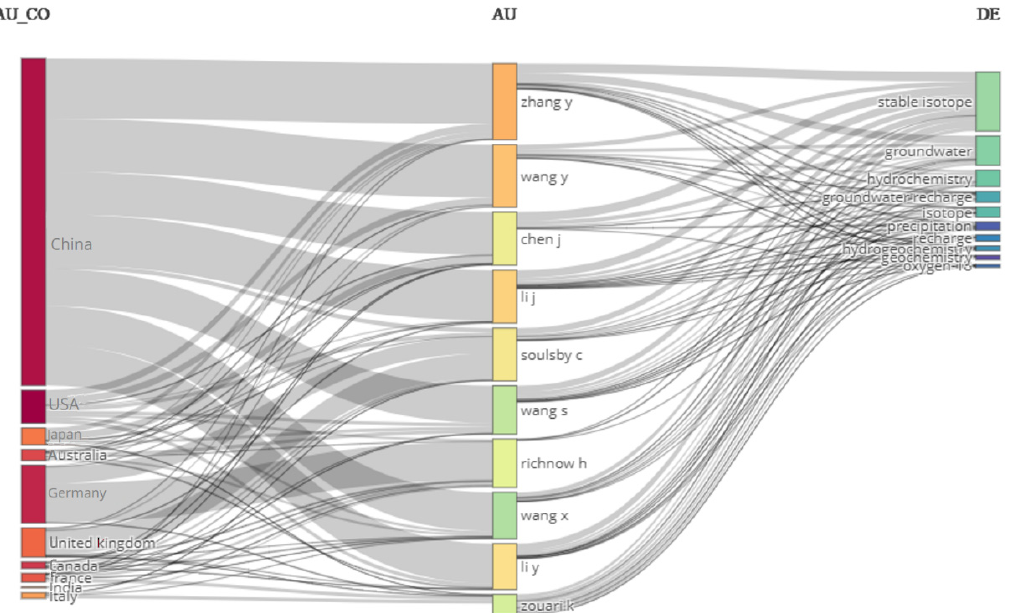
Figure 5. Author-Country-Keyword relation.